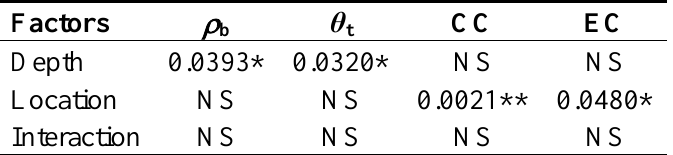
), porosity ( θ ), clay content (CC), and b t